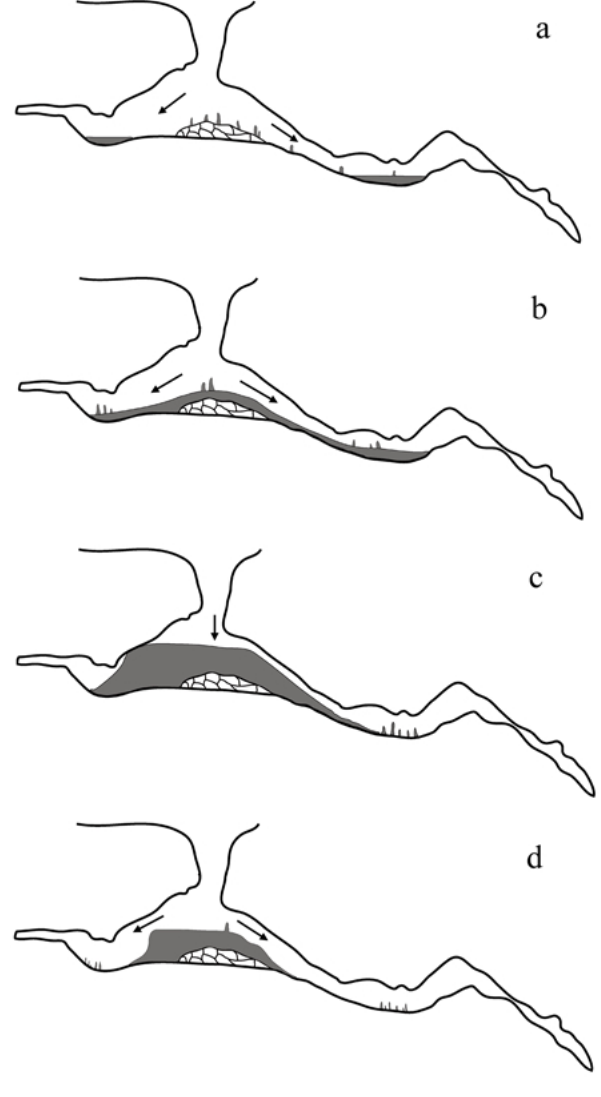
Fig. 6. A conceptual model of the genesis and long-term volume fluctuations of the ice block in Sc˘aris¸oara Ice Cave (see main text for details). Arrows indicate the direction of cold air